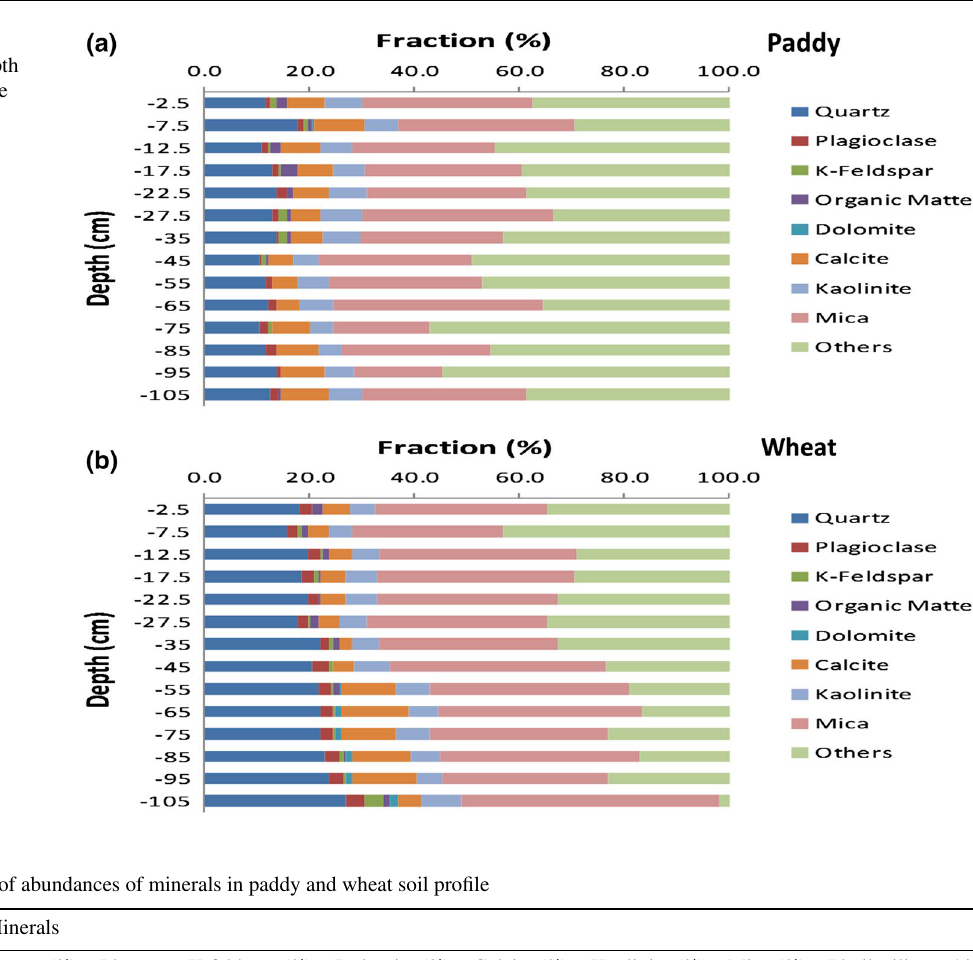
Fig. 5 Variation of mineral composition of soils with depth along paddy and wheat profile